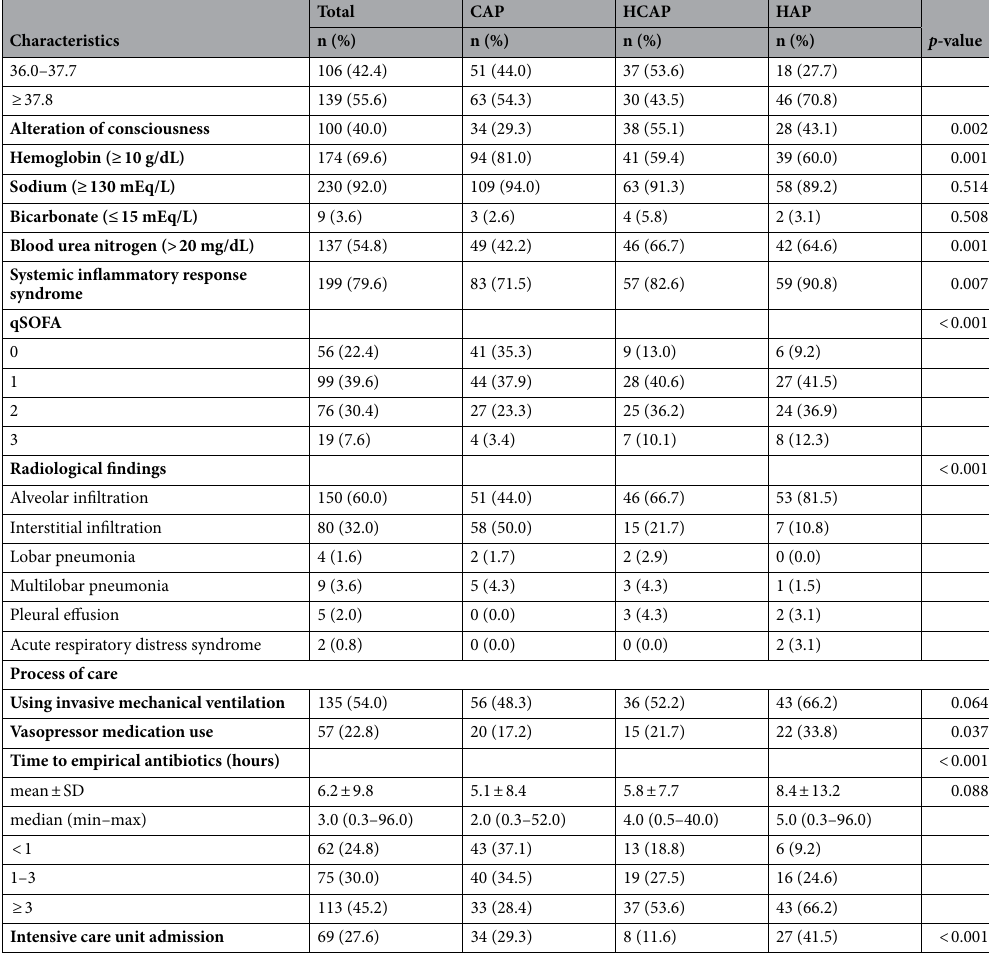
Table 1. Baseline characteristics of participants (N = 250). CAP; community-acquired pneumonia, HCAP; healthcare-associated pneumonia, HAP; hospital-acquired pneumonia, qSOFA; quick sequential organ failure assessment, SD; standard